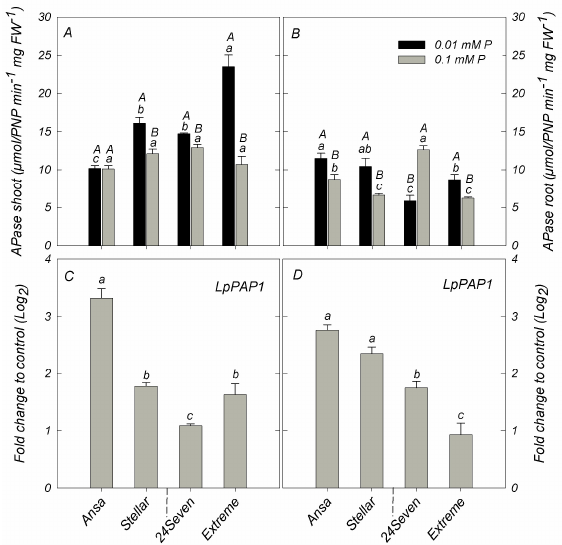
Figure 5. Acid phosphatase activity in shoots ( A ); and roots ( B ); and expression analysis of purple acid phosphatase LpPAP1 in shoots ( C ); and roots ( D ) of ryegrass cultivars hydroponically grown at optimal (0.1 mM P) and deficient (0.01 mM P) P conditions. All data were normalized to geometric mean value from LpeEF1 α (h) and LpeEF1 α (s) housekeeping genes and expressed as fold change of control treatment (0.1 mM P). Log2 was performed to better understand the regulation of these genes. Values represent the mean (n = 3) ± standard error. Different uppercase letters indicate statistically significant differences (Tukey’s HSD at p ≤ 0.05) between P treatments for the same cultivar. Different lowercase letters indicate statistically significant differences (Tukey’s HSD at p ≤ 0.05) among ryegrass cultivars at the same P